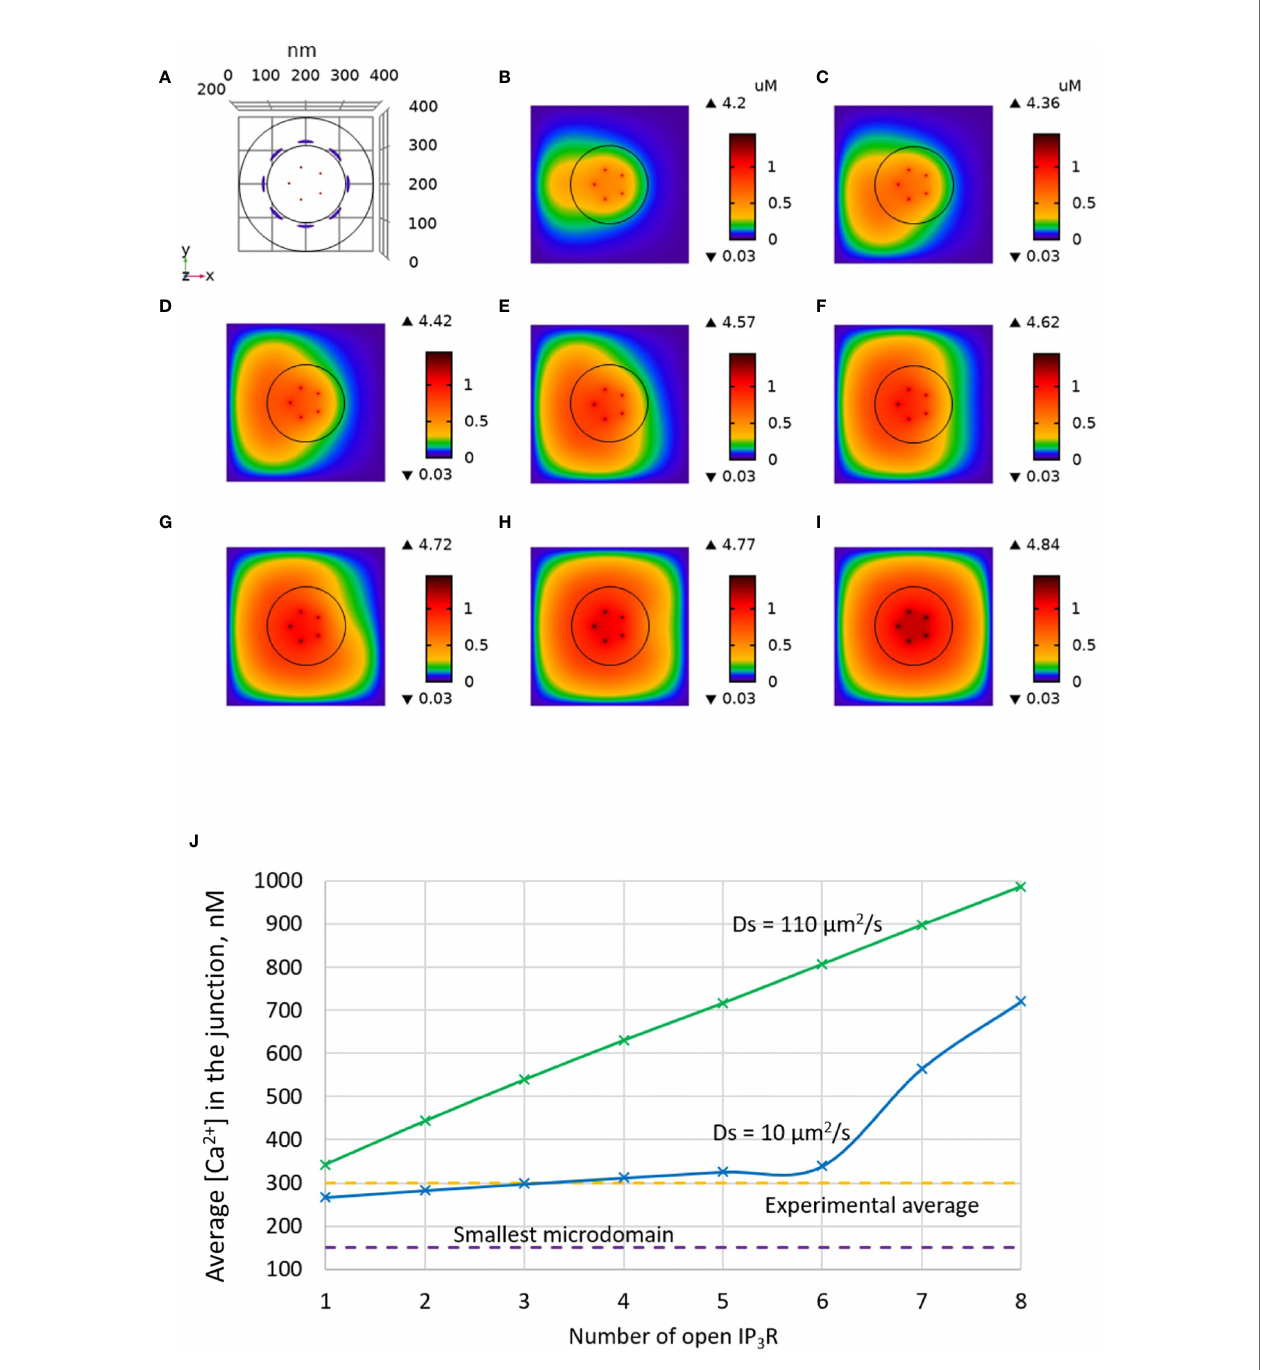
FIGURE 5 | In fl uence of the value of the Ca 2+ diffusion coef fi cient in the ER (D S ) on the Ca 2+ microdomains in the ER-PM junction. (A) Upper view of the arrangement of the ORAI1 channels on the PM of the junction (red dots) and of the adjacent IP 3 Rs (blue lines) using COMSOL. (B – I) Steady-state Ca 2+ pro fi les in the junction when opening 1 (B) to 8 (I) IP 3 Rs simultaneously with D S = 110 m m 2 /s. Left bars indicate the color codes, together with the minimal and maximal concentrations reached in the related panels. Shown are the pro fi les 22ms after opening of the IP 3 Rs. Upon depletion of local Ca 2+ in the ER, which is quasi- instantaneous, ORAI1 channels open to an extent that depends on this local concentration, as de fi ned by the function f (see Supplementary Information ). ORAI1 opening is assumed to occur immediately after depletion because ORAI1-STIM2 aggregates are pre-formed (4). (J) Evolution of the amplitude of the simulated Ca 2+ microdomains with the number of simultaneously open IP 3 Rs in the junction. Results obtained with the default value for D S (10 m m 2 /s) corresponding to the results shown in Figure 3 are also indicated for